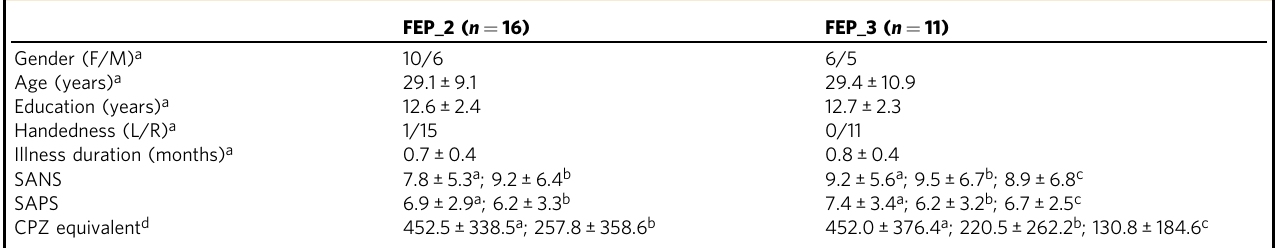
Table 6 Group average statistics (±SD) of the FEP_2 and FEP_3. FEP_2 ( n = 16) FEP_3 ( n = 11)